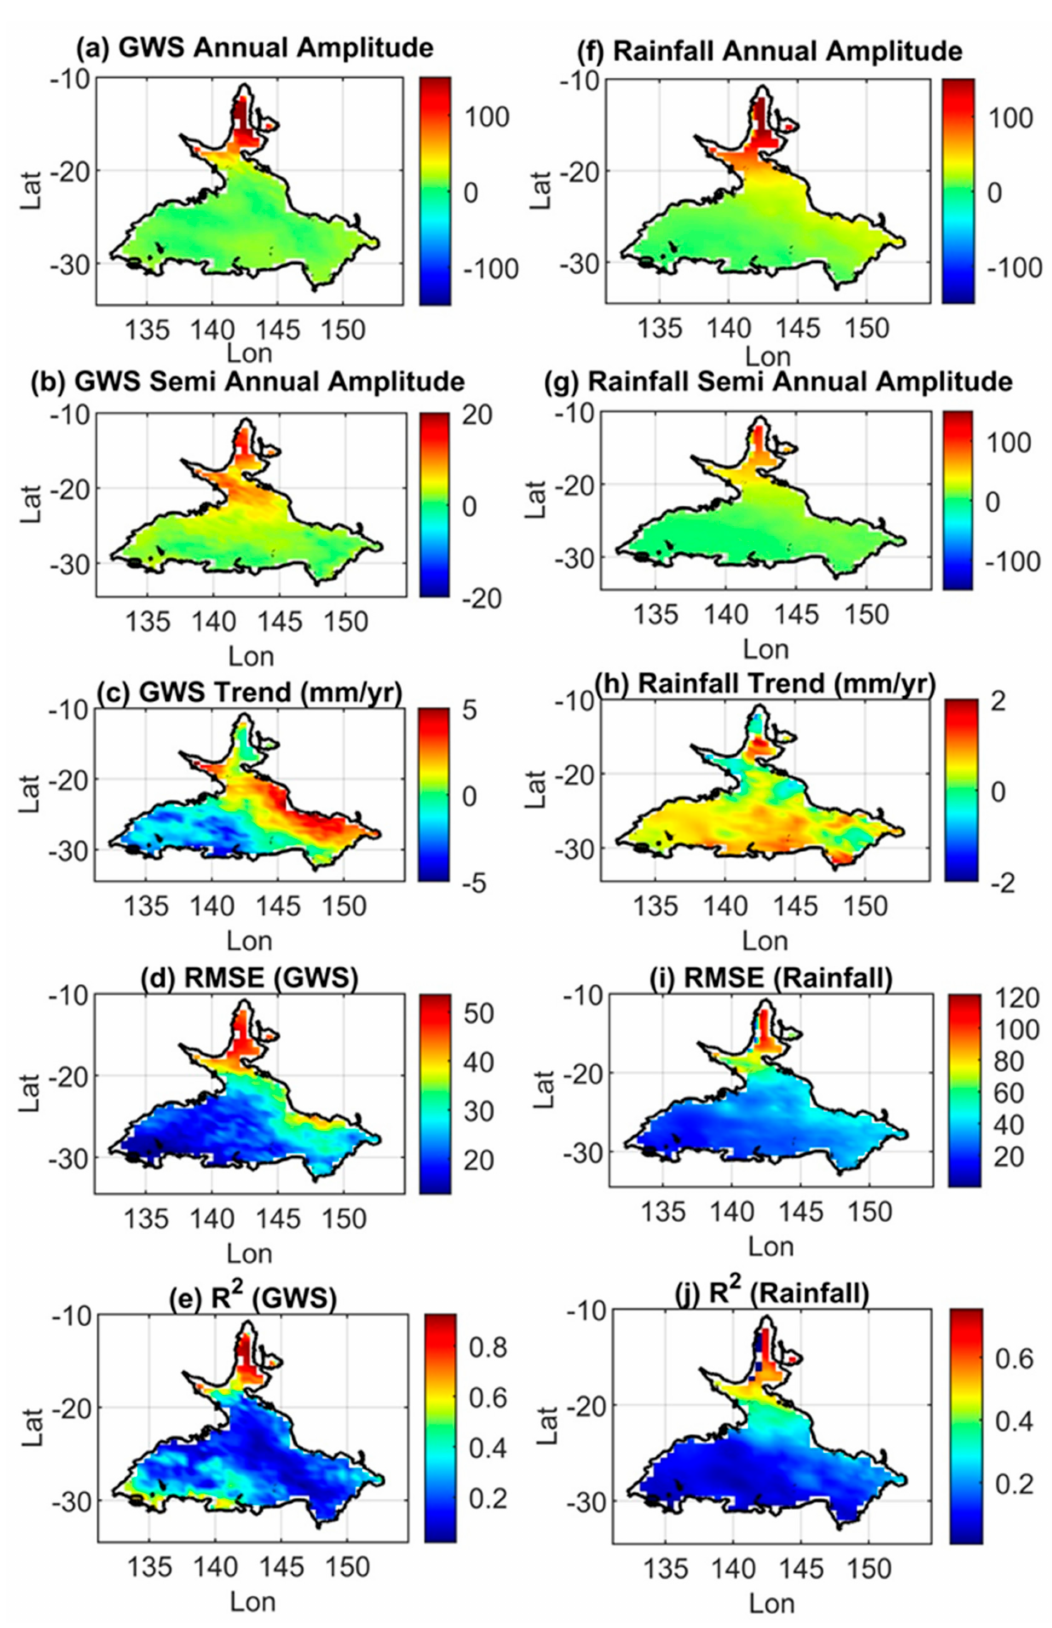
Figure 10. Spatial patterns in annual and semi-annual components of variation and trends in GWS ( a – c ) and rainfall ( f – h ) over the GAB between 2002 and 2017 estimated using multi-linear regression analysis. RMSE ( d , i ) and R 2 values ( e , j ) for each response variable are also